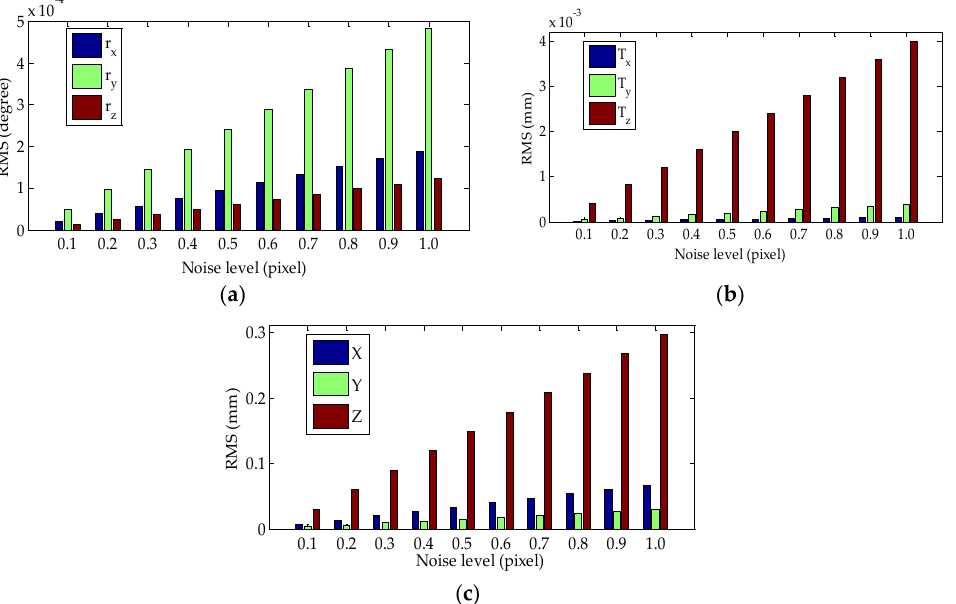
Figure 5. Performance of the proposed calibration method with respect to noise: ( a ) RMS of r x , r y , and r z at various noise levels; ( b ) RMS of T x , T y , and T z at various noise levels; ( c ) RMS of X , Y , and Z at various noise levels.